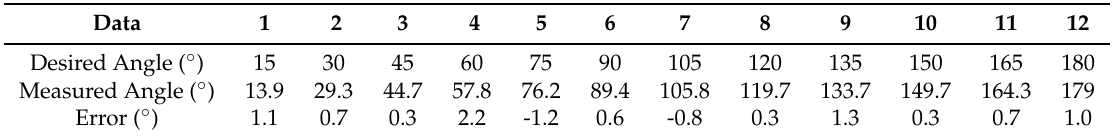
Table 2. Experimental Results.